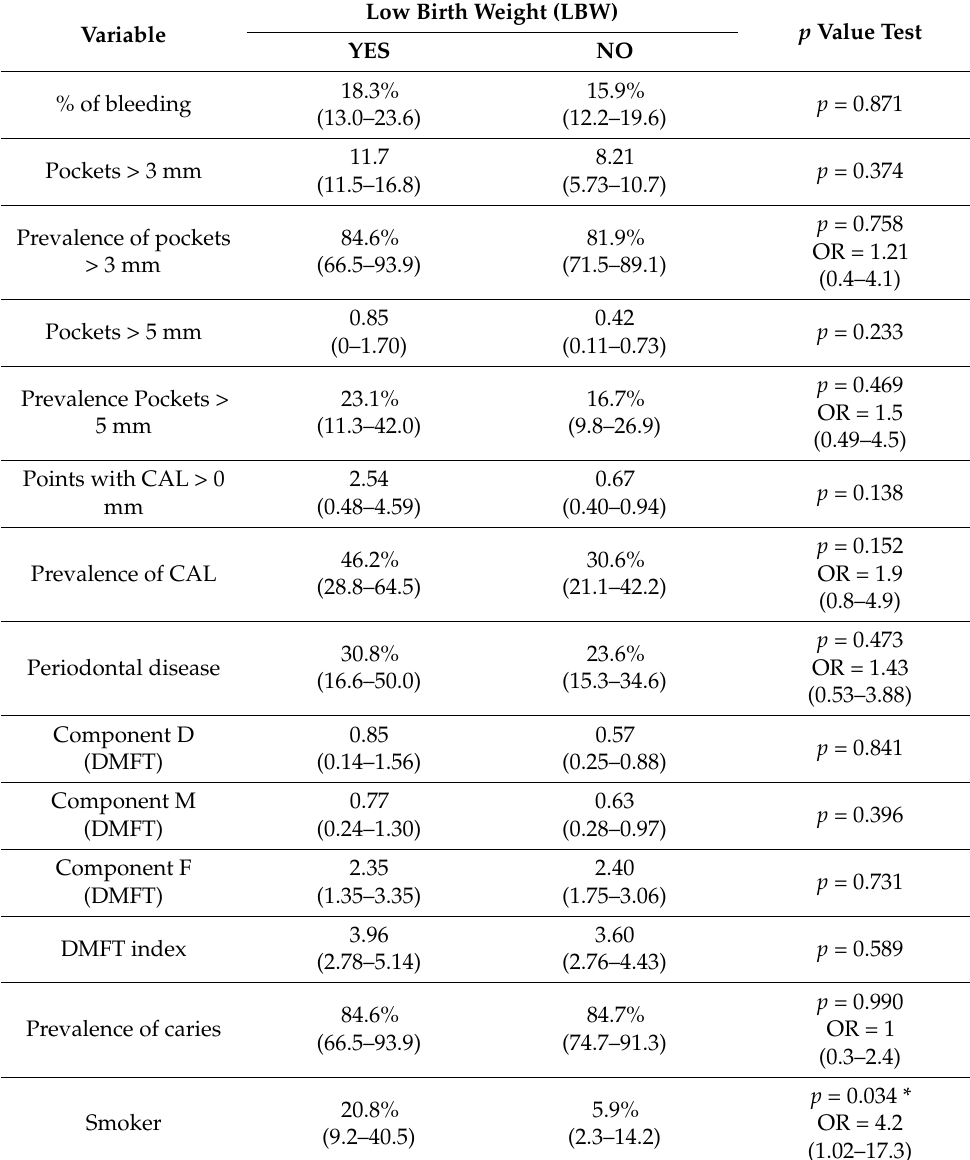
Table 4. Oral health status according to low birth weight